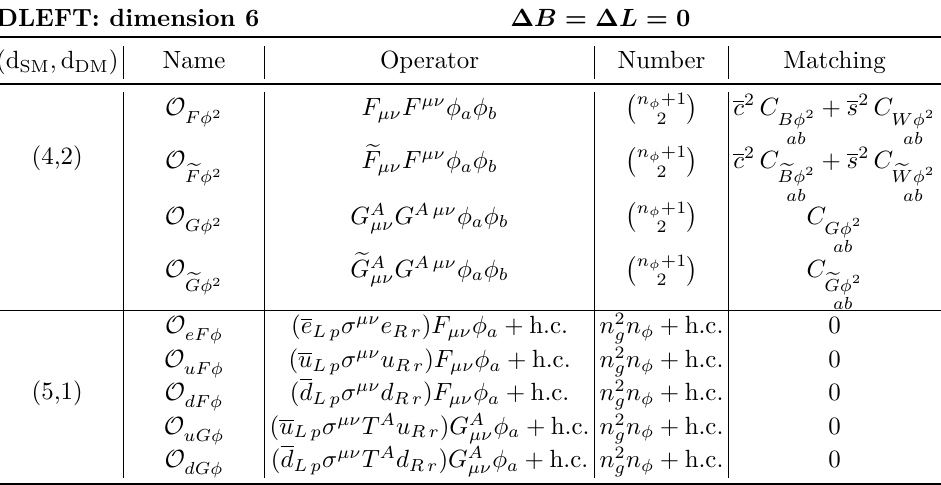
Table 23 . Dimension-six ∆ B = ∆ L = 0 operators in DLEFT, part 4. The first column gives the dimensions of the SM and DM part of the operator, the fourth column is the number of operators, and the fifth column is the additional matching contribution at the EW